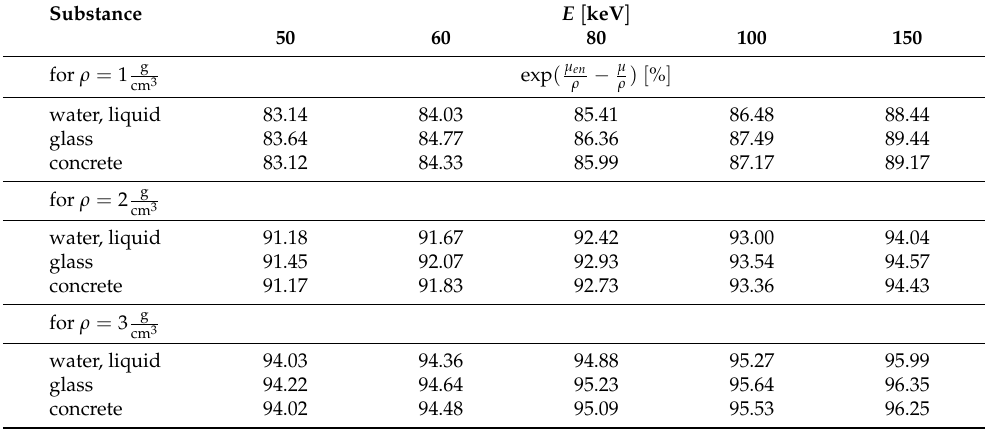
Table A2. Mass energy absorption and mass attenuation